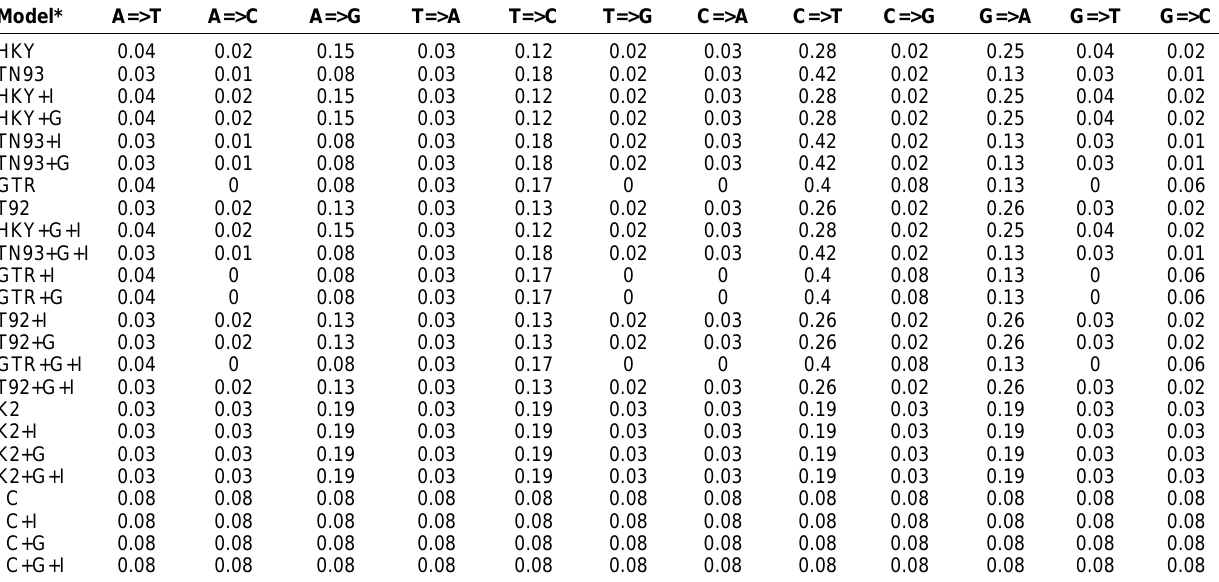
Table-5. Nucleotide Substitution rates calculated by various models in Intron I of OLR1 of Buffalo